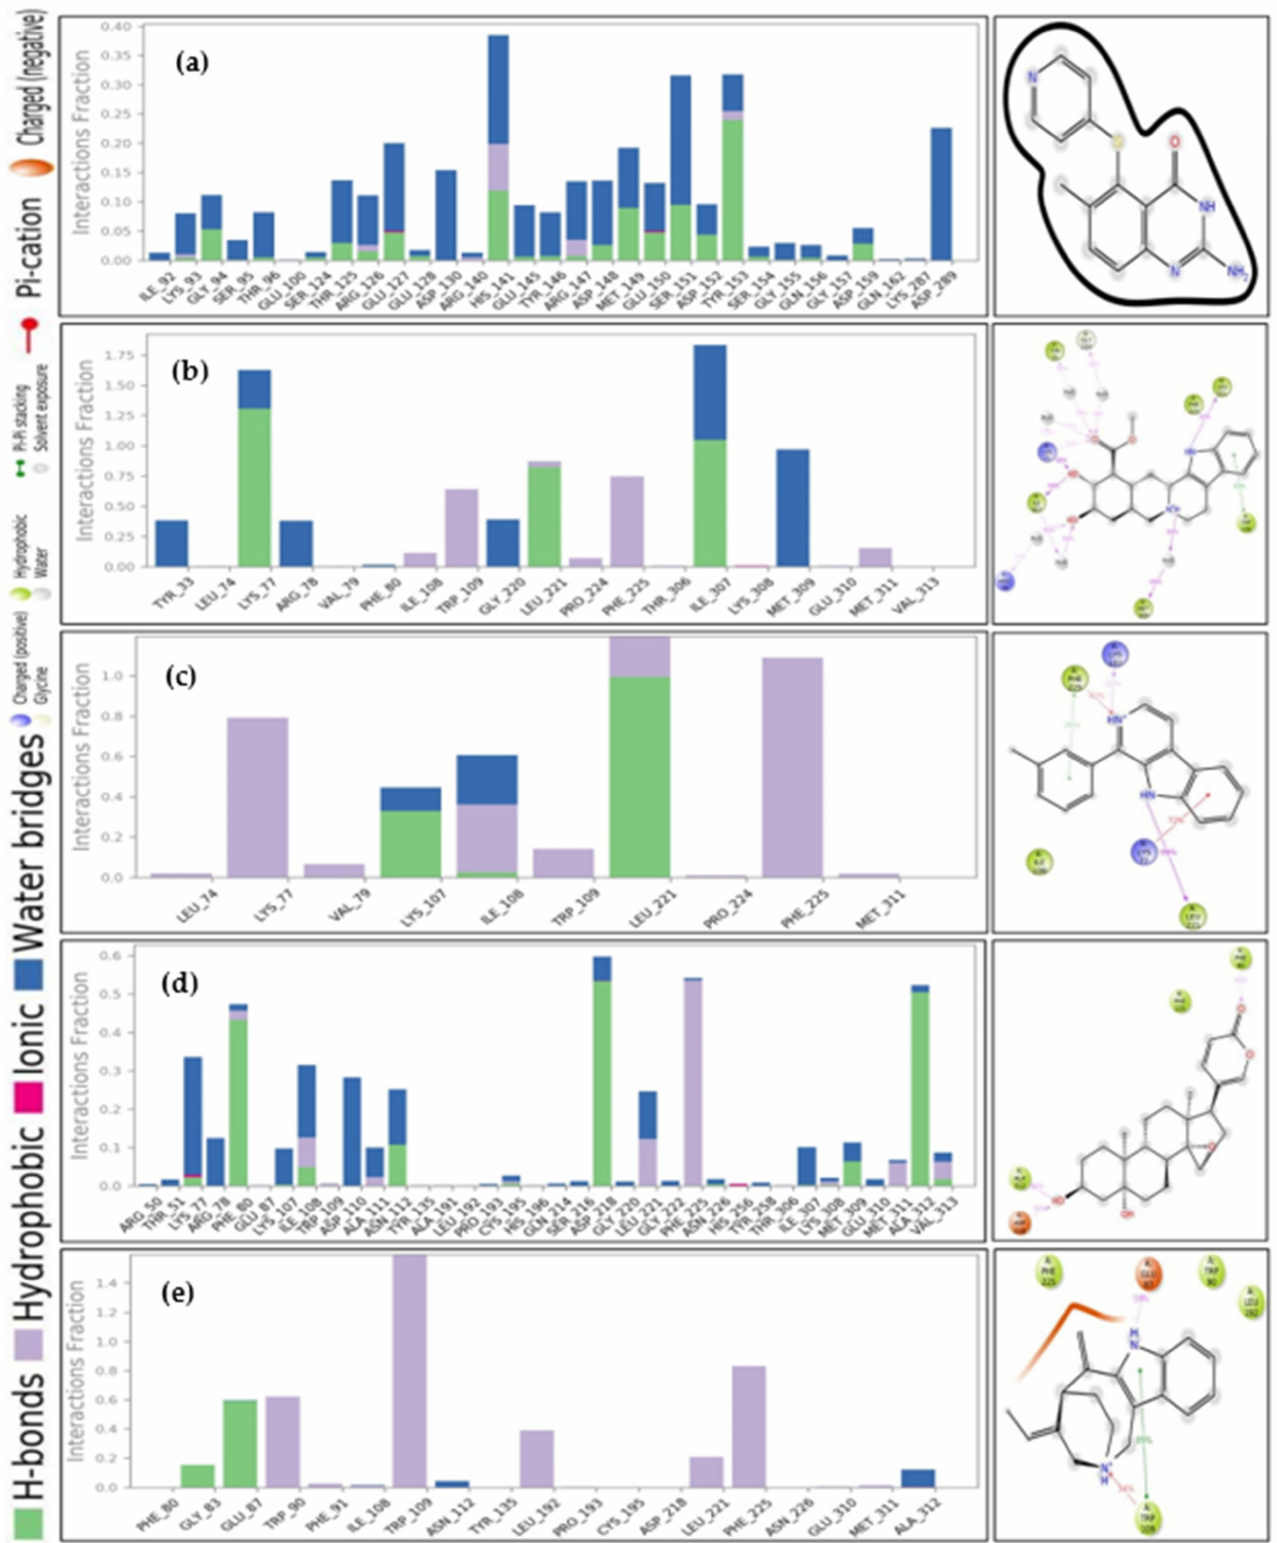
Figure 13. Bar graphs presenting ligand-protein interaction of the: ( A ) PubChem CID: 135400184; ( B ) PubChem CID: 102004710; ( C ) PubChem CID: 198912; ( D ) PubChem CID: 11969465; and ( E ) Pub- Chem CID: 5281349 compounds to 50 ns MD